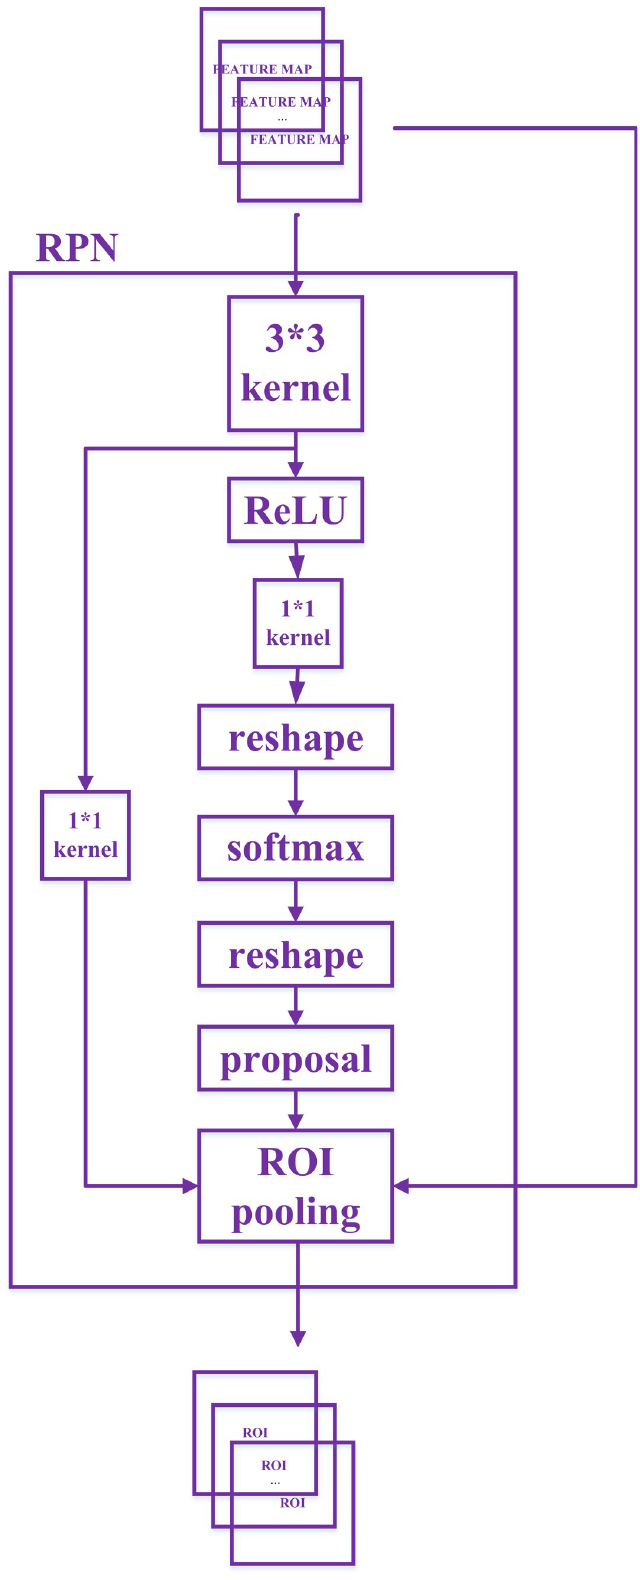
Fig 4. The ROI extraction